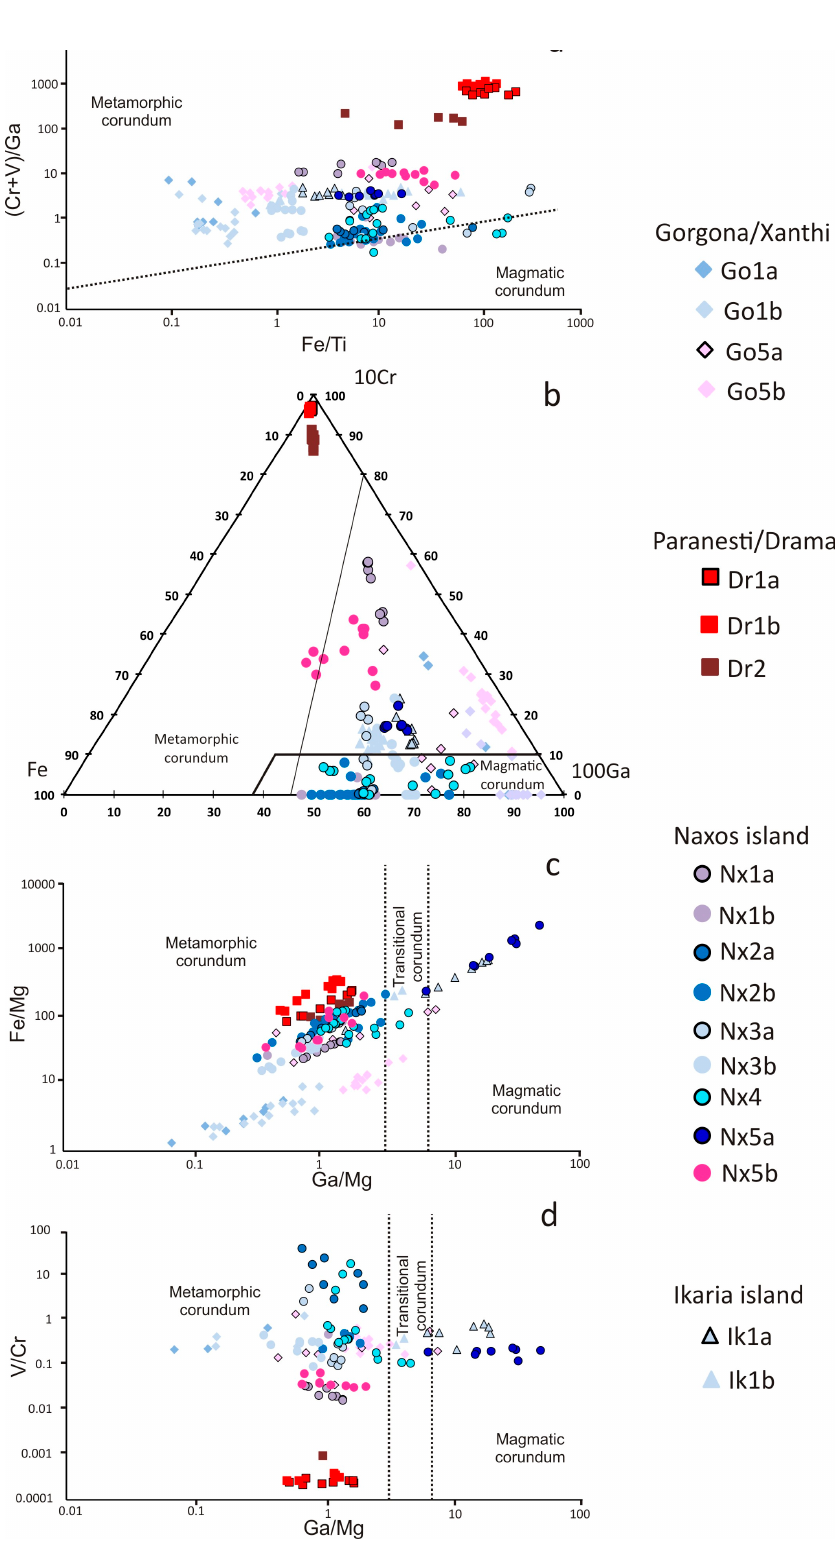
Figure 9. Greek corundum LA-ICP-MS analyses plotted on a ( a ) (Cr + V)/Ga versus Fe/Ti discrimination diagram separating the fields for magmatic and metamorphic corundums (after Sutherland et al. [84] and Harris et al. [85]); ( b ) trace element Fe – Cr × 10 – Ga × 100 discrimination diagram after Sutherland et al. [84]; ( c ) Fe/Mg versus Ga/Mg diagram discrimination separating the fields for magmatic, transitional and metamorphic corundums (after Peucat et al. [16], Sutherland et al. [84]; ( d ) V/Cr versus Ga/Mg discrimination diagram separating the fields for magmatic, transitional and metamorphic corundums (after Sutherland et al. [86]).